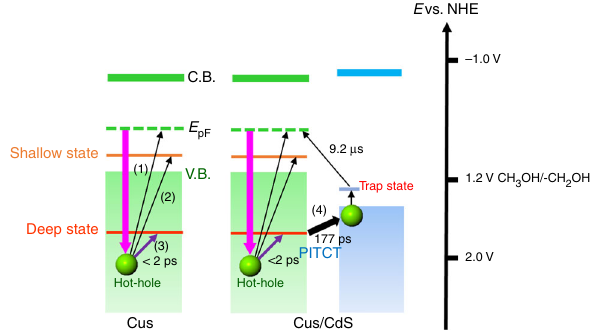
Fig. 4 Schematic illustration of LSPR-induced stepwise hole transfer process. Decay processes of hot holes generated in CuS NCs and CdS/CuS HNCs are shown. The red arrows means plasmon excitation by near- infrared (NIR) light. For CuS NCs, the generated hot holes decayed via hole – hole and phonon – hole scattering (1) or ultrafast hole trapping to the shallow (2) or deep trapping state (3), followed by relaxation to the intrinsic hole state. In CdS/CuS heterostructured nanocrystals (HNCs), the holes in the deep trapping state transferred to the valence band (VB) of the CdS phases (4, PITCT) and the holes in the CdS phases moved to the trapping state, showing structureless absorption in the visible region and recombination to the initial state. PITCT: plasmon-induced transit carrier